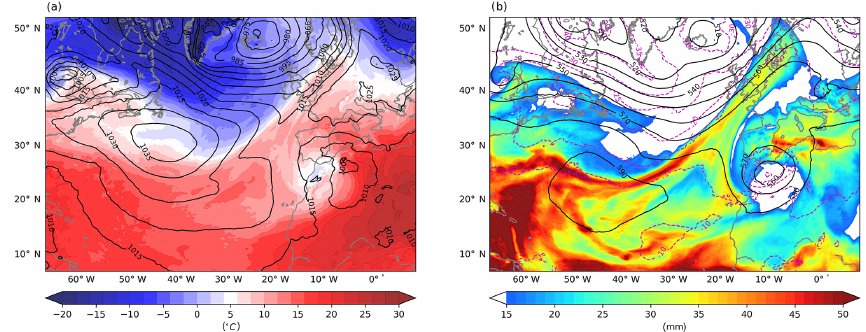
Figure 3. Synoptic situation (from the WRF simulation) on 20 October 1982, at 12:00UTC. (a) Mean sea level pressure (contours; hPa) and 850hPa temperature (colours; ◦ C). (b) Geopotential height (solid black contours; dam) and temperature (magenta dashed contours; ◦ C) at 500hPa and total precipitable water (colours; mm).